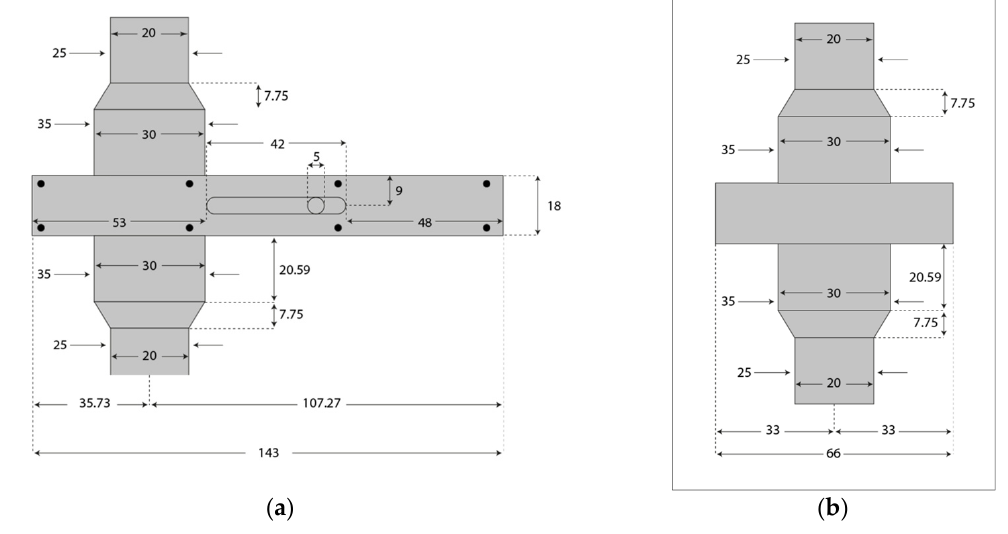
Figure 9. Second valve geometry. ( a ) Front view; ( b ) side view.